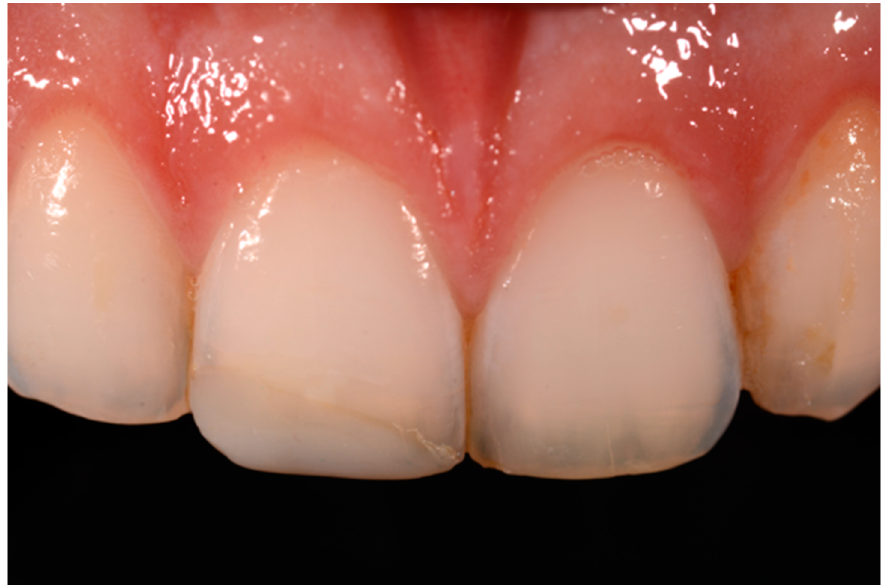
Figure 48. Initial clinical situation.